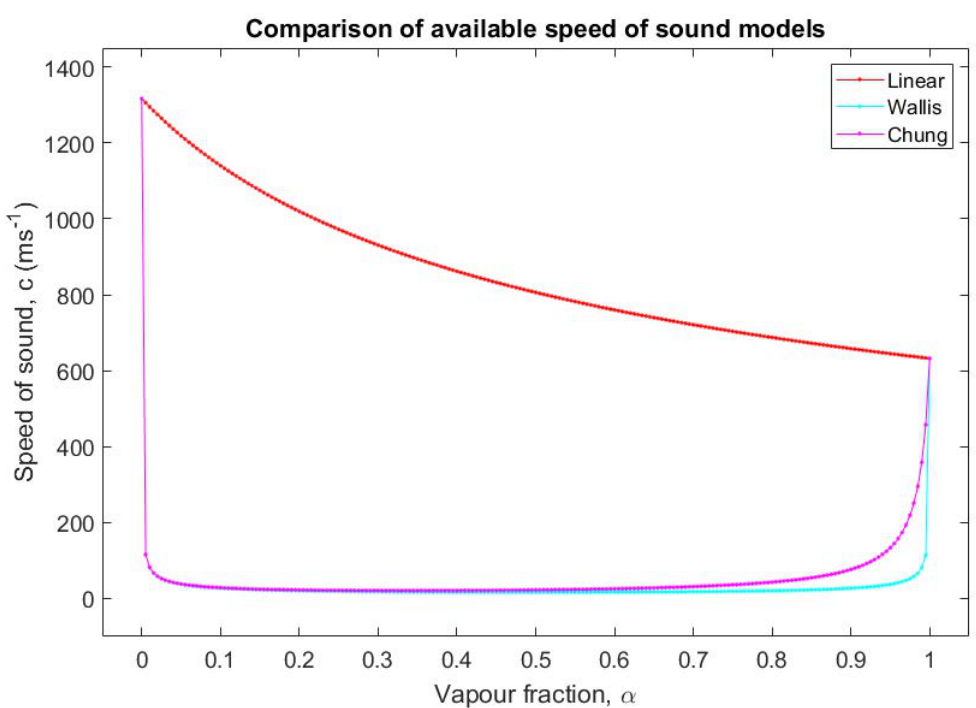
Figure 3. Speed of sound comparison calculated using three compressibility models (linear, Wallis and